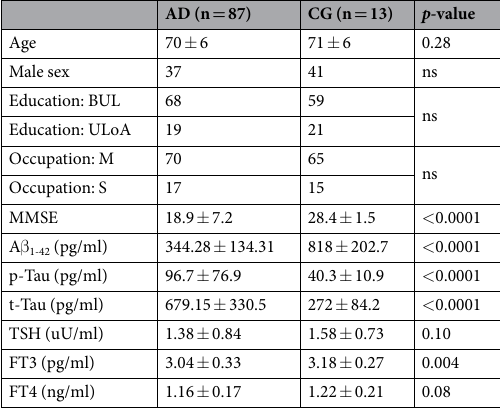
Table 1. General overview of the AD population examined, including sociodemographic variables. BUL: below university level; ULoA: university level or above; M: manual; S: